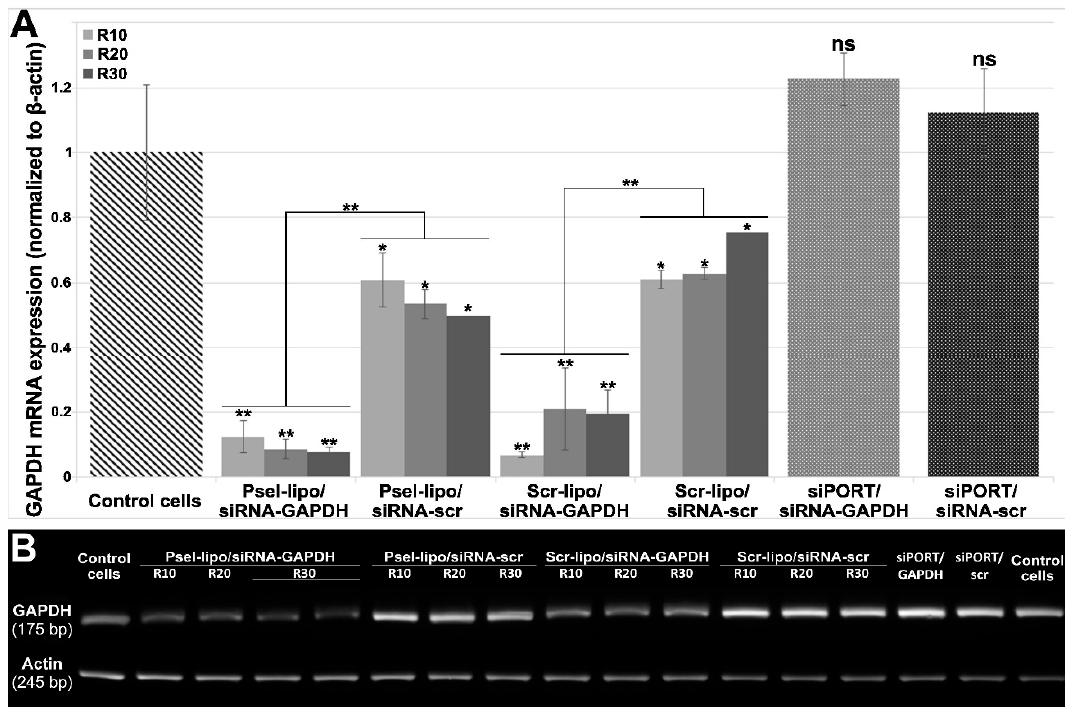
Figure 7. ( A ) The expression of GAPDH mRNA in b.End3 cells was significantly reduced by Psel-lipo/siRNA-GAPDH (100 nM siRNA). GAPDH mRNA expression was determined by quantitative RT-PCR at 48 hours after transfection using different vectors. The relative levels of GAPDH mRNA were normalized using β -actin as an internal control. ( B ) Agarose gel electrophoresis run with amplicons obtained after real-time PCR reactions. The data are representative of three independent experiments. **p < 0.01, *p < 0.05, ns: non-significant versus control cells; **p < 0.01 Psel-lipo/siRNA- GAPDH versus Psel-lipo/siRNA-scr and Scr-lipo/siRNA-GAPDH versus Scr-lipo/siRNA-scr.